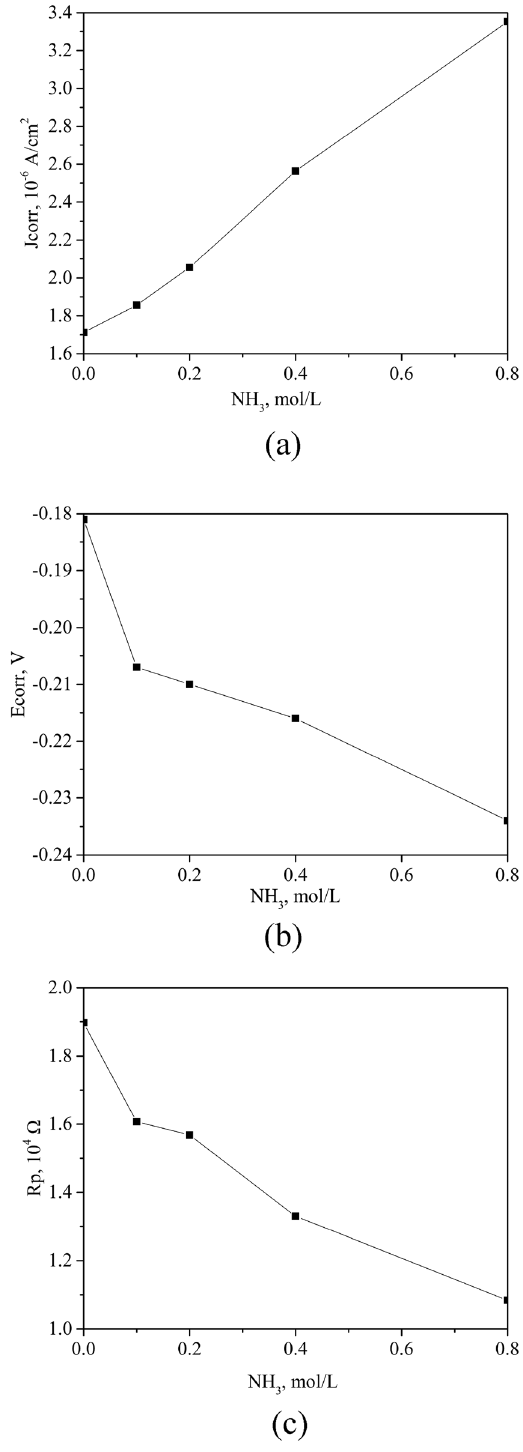
Figure 4: Electrochemical parameters of gold dissolution with di ff erent ammoniacal concentrations: ( a ) corrosion current density of gold dissolution; ( b ) corrosion potential of gold dissolution; and ( c ) polarization resistance of gold dissolution.